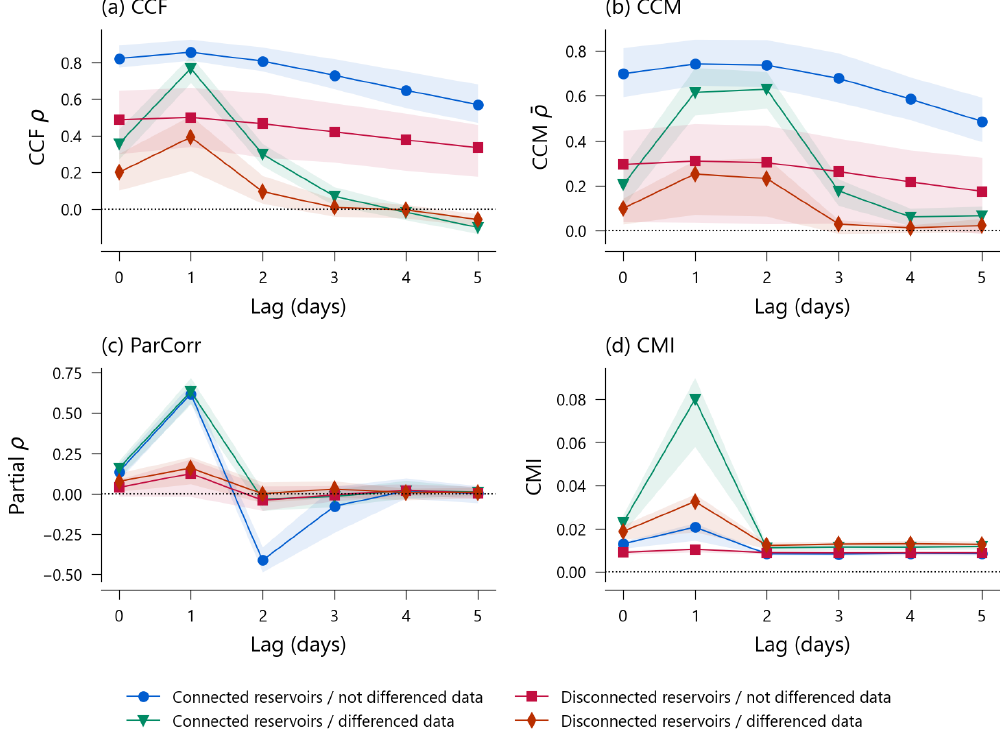
Figure 3. Patterns of statistical time dependencies between Q A and Q b ( Q (cid:48) statistics for 56 synthetic datasets obtained from four different model structures (Table 3) and 14 distinct noise levels. The envelope represents the interquartile range of the statistics. In general, connected reservoirs show Q A → Q (cid:48) for CMI on the non-differenced data, disconnected reservoirs show a non-causal yet significant statistical dependency Q A → Q B at lag 1d, since reservoir A mostly reacts 1d before B to the effective